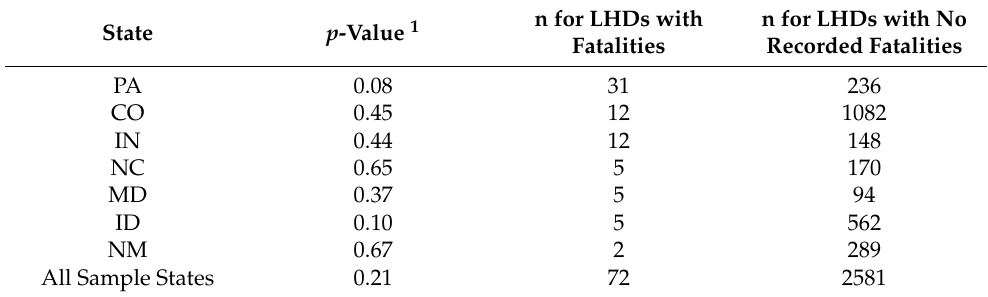
n for LHDs with n for LHDs with No Fatalities Recorded Fatalities